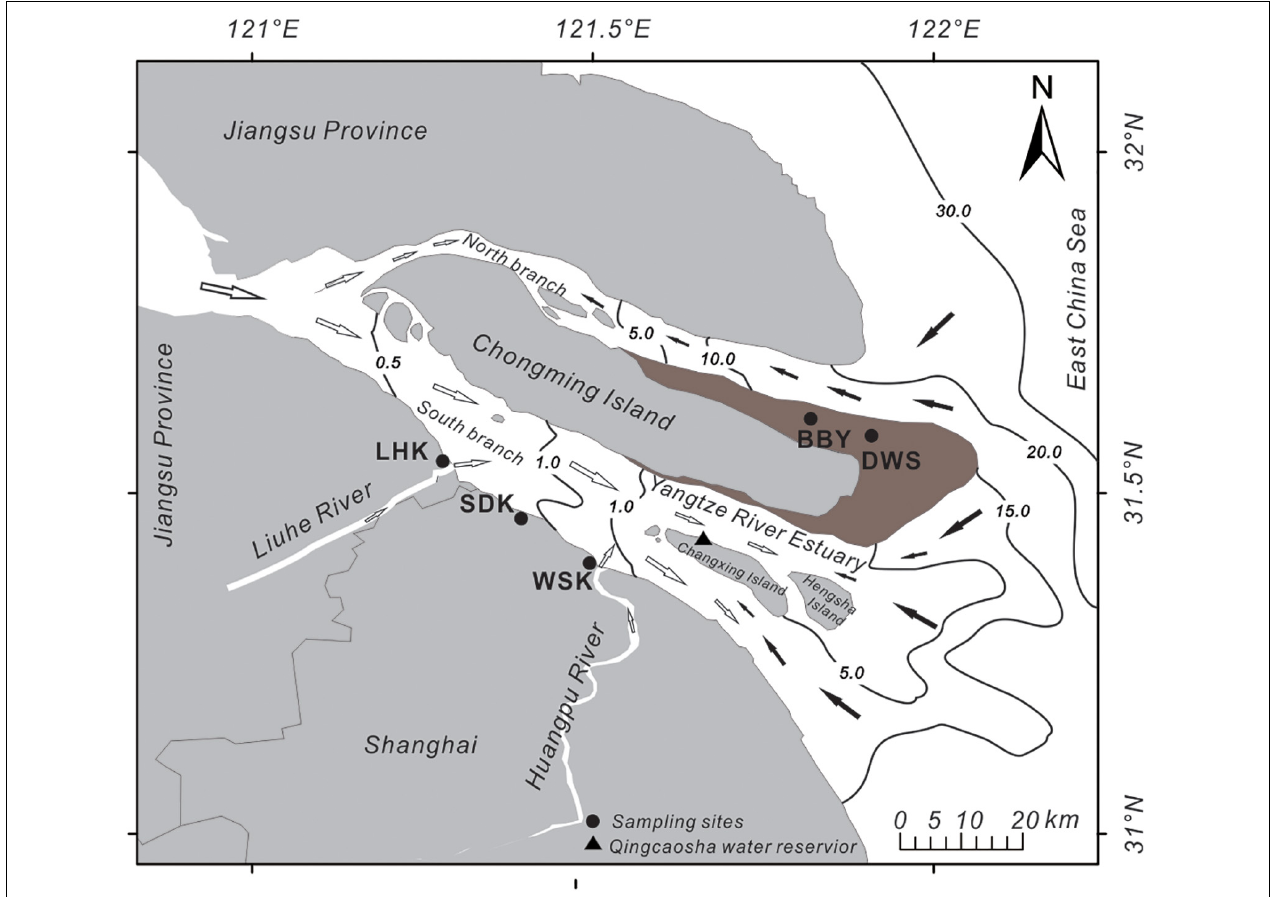
FIGURE 1 | Map of the locations of the five sampling sites at the Yangtze River estuary. LHK, SDK, and WSK sample sites are estuarine mudflats; BBY and DWS sample sites are salt marshes. Black arrows indicate the direction of incoming saltwater; white arrows indicate the direction of downstream freshwater. Numbered black lines indicate salinity